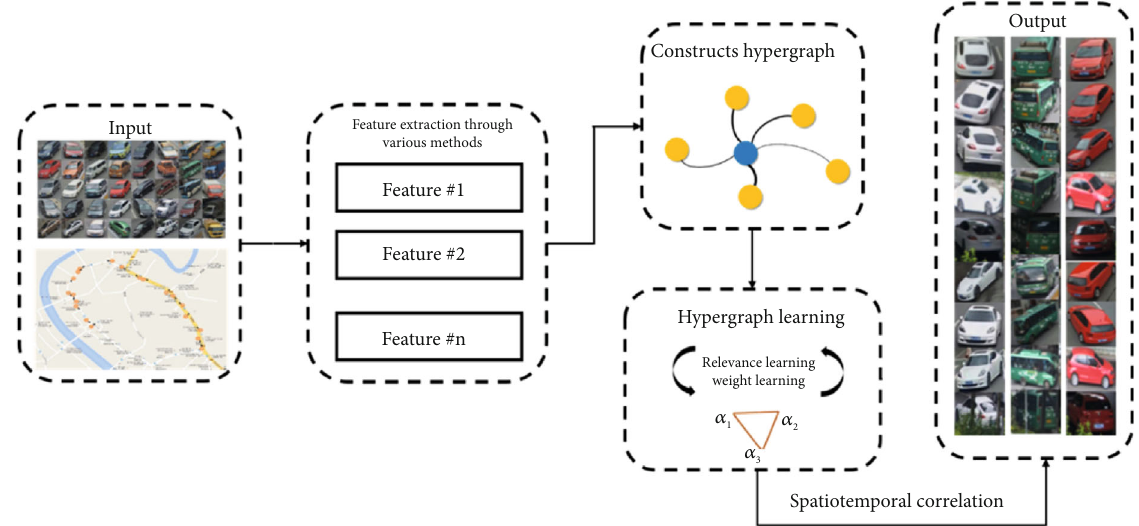
Figure 1: Overview of vehicle reidenti fi cation methods based on multifeature hypergraph